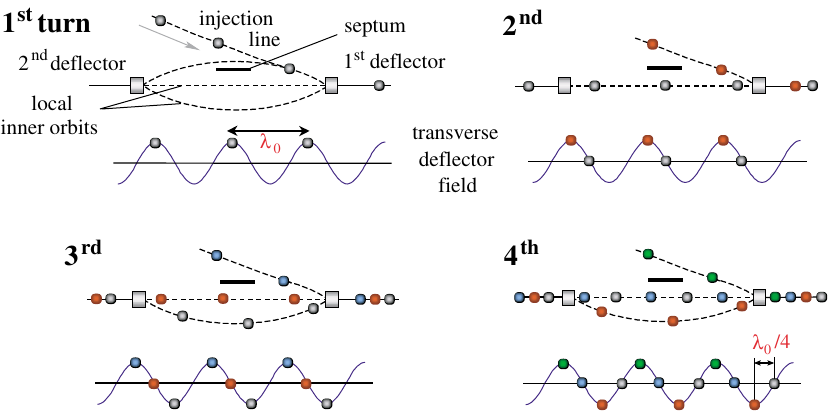
FIG. 2. (Color) Bunch train combination by injection with rf deflectors for a multiplication factor 4. The images show the injection region of the ring for four successive turns of injected bunches and the corresponding bunch distribution on the rf field of the